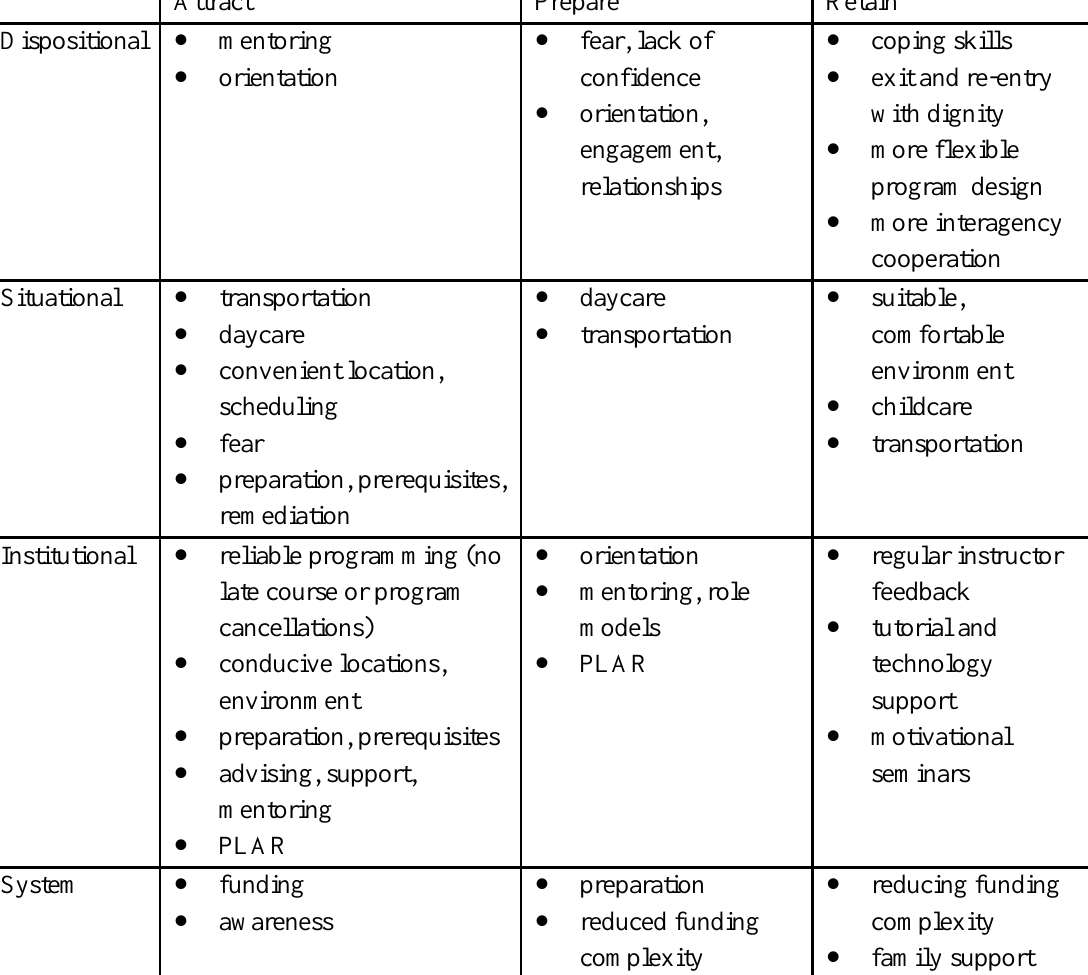
Table 3 Critical Influences on Attraction, Preparation, and Retention Attract Prepare Retain